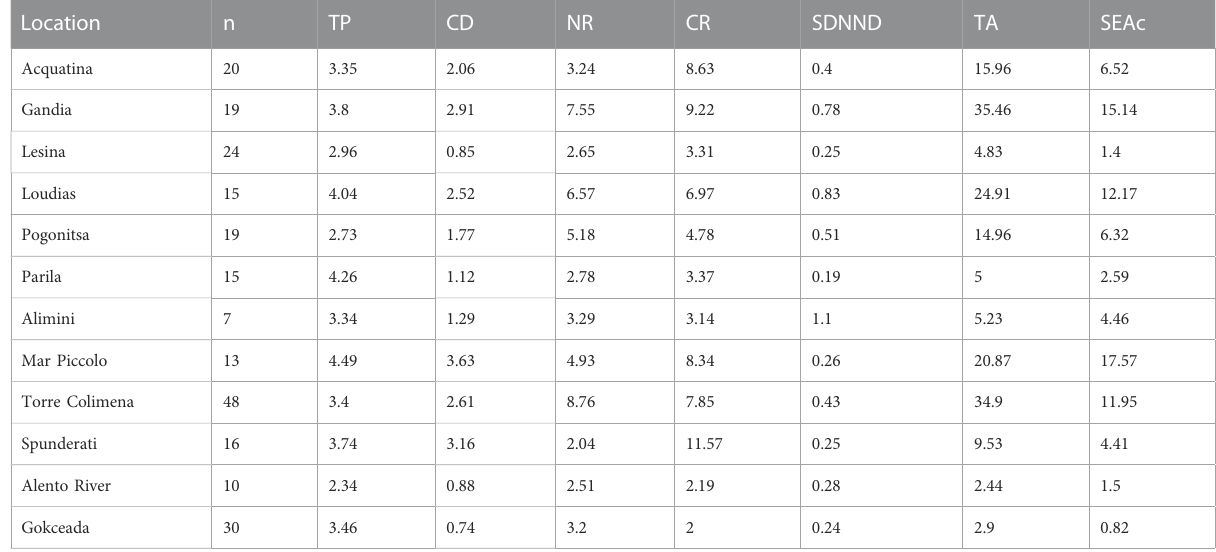
TABLE 3 Sample number (n), trophic position (TP), mean distance to centroid (CD), nitrogen range (NR), carbon range (CR), standard deviation of nearest neighbor distance (SDNND), total area (TA), and corrected standard ellipse area (SEAc) of the 12 Callinectes sapidus populations included in the individual- scale dataset.